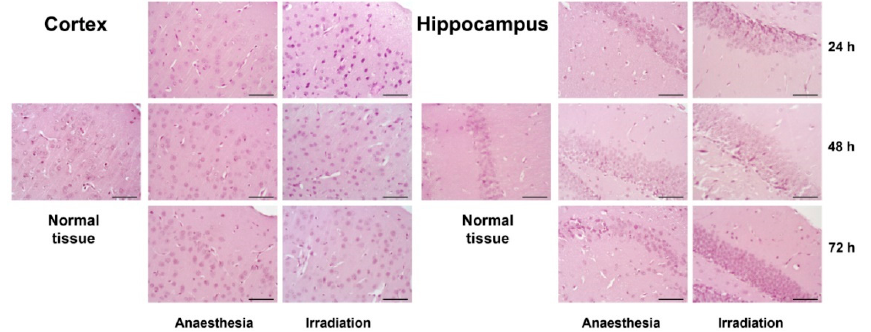
Figure 2. Morphology of cerebral cortex and hippocampus in the control and irradiated mouse brain tissues 24, 48 or 72 h after triple irradiation. Haematoxylin-Eosin staining. Magnification ×400, scale bar size 50 µm.